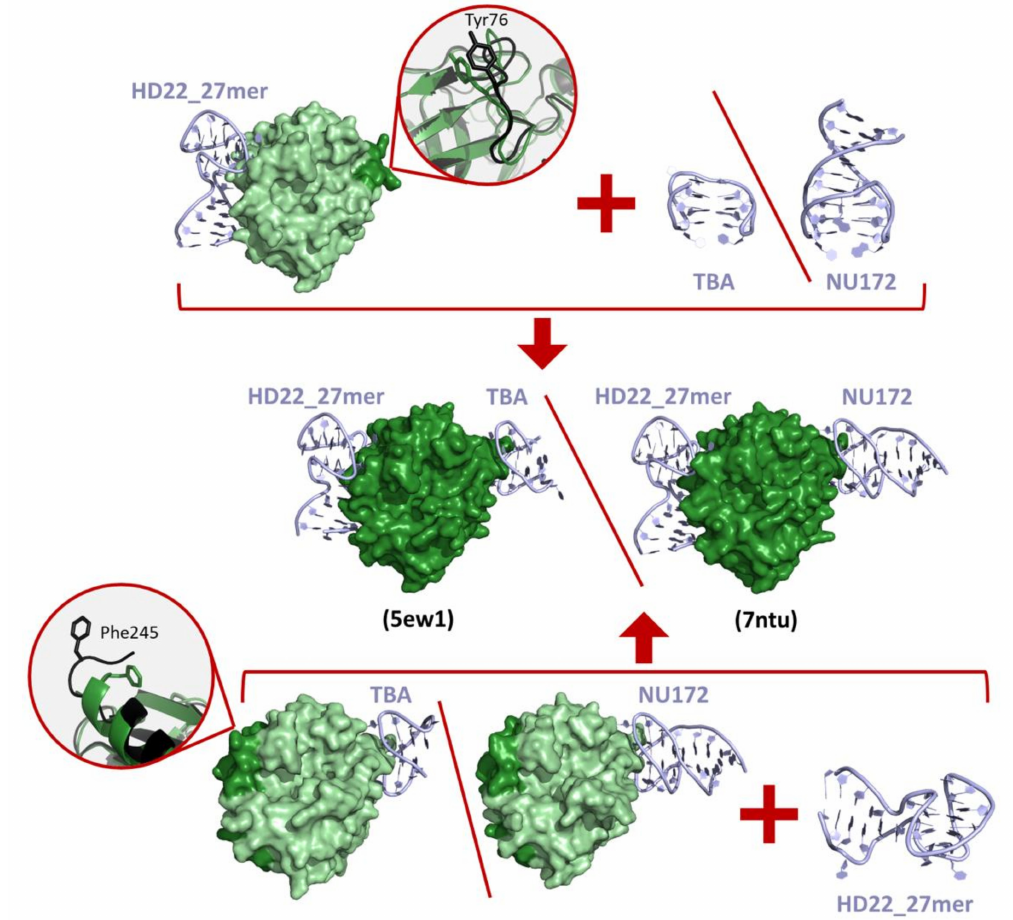
Figure 10. Simultaneous binding of TBA or NU172 (exosite I) and HD22_27mer (exosite II) to thrombin. MD studies [111,112] have shown that the HD22_27mer binding at the exosite II favors conformations of exosite I that are prone to the TBA/NU172 association (on the top) and vice versa (on the bottom). The conformational variations of the exosite I region between free (black) and HD22_27mer-bound (dark green) thrombin is highlighted in the inset on the top. Similarly, the conformational rearrangements of the protein C-terminus belonging to the exosite II between free (black) and TBA-bound or NU172-bound (dark green) thrombin is highlighted in the inset on the bottom. The crystallographic structures of the ternary complexes are shown in the middle (the PDB entries are reported within